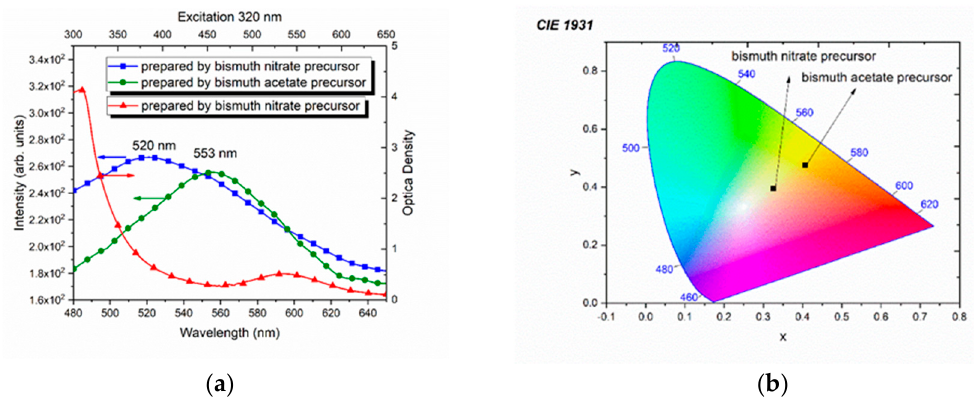
Figure 5. ( a ) Optical absorption spectrum of the sample prepared by the bismuth nitrate precursor and emissions spectra of the samples prepared by the bismuth nitrate and bismuth acetate precursors.